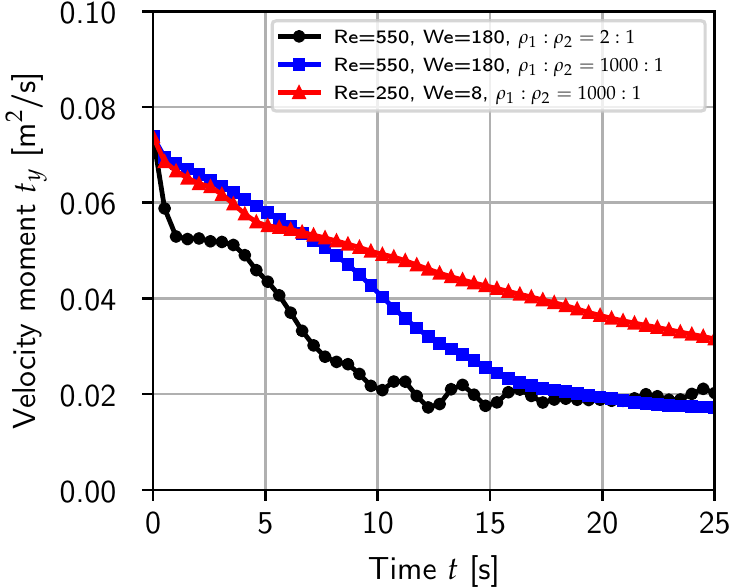
Figure 17. Evolution of the velocity moment of the droplets about the domain’s center along the y-axis for all cases.